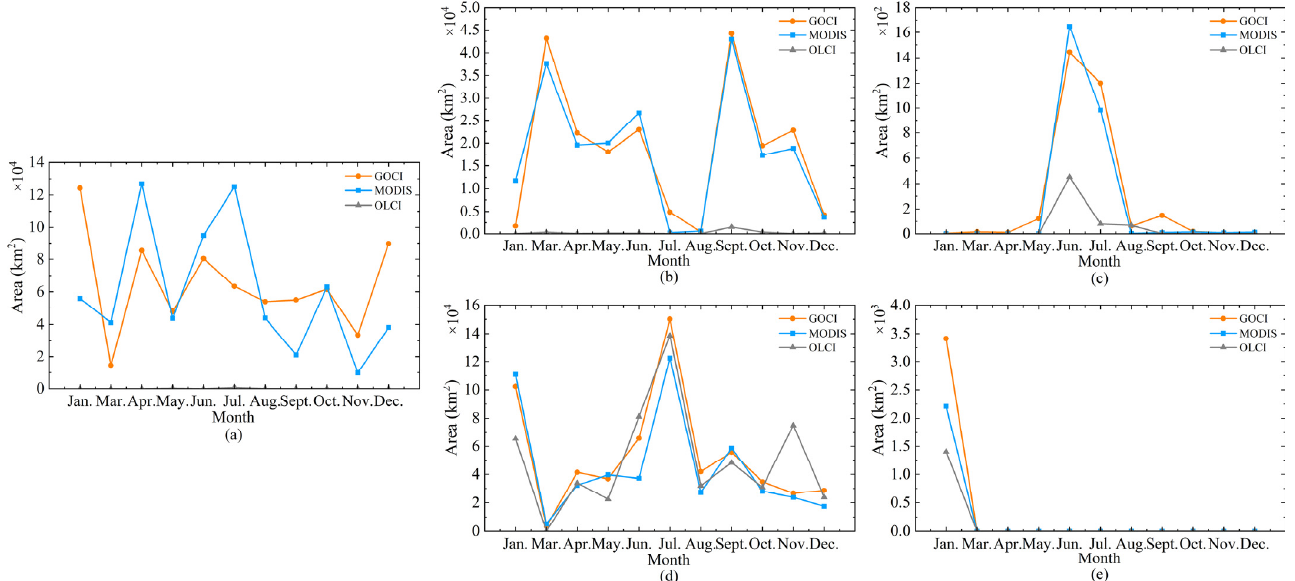
Figure 10. Schematic diagram of the distribution of total missing marine coverage types for all sea- sons for the three products: ( a ) clean water, ( b ) turbid water, ( c ) green tide algae, ( d ) clouds and ( e ) sea ice.